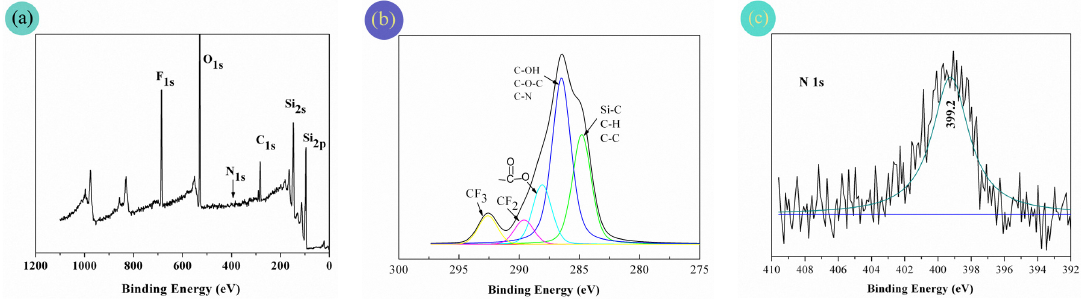
Figure 7. XPS spectra: ( a ) wide spectrum; ( b ) C 12S high resolution spectrum and ( c ) N 1S high resolution spectrum. Strong O 1s (O 1s at 532.0 and 533.5 eV) and F 1s (F 1s at 688.4 and 691.0 eV), moderate Si 2s and Si 2p (Si 2s at 153.0 eV and Si 2p at 102.0 eV), and C 1s spectra appeared for the PFAS ‐ coated fabric surface.